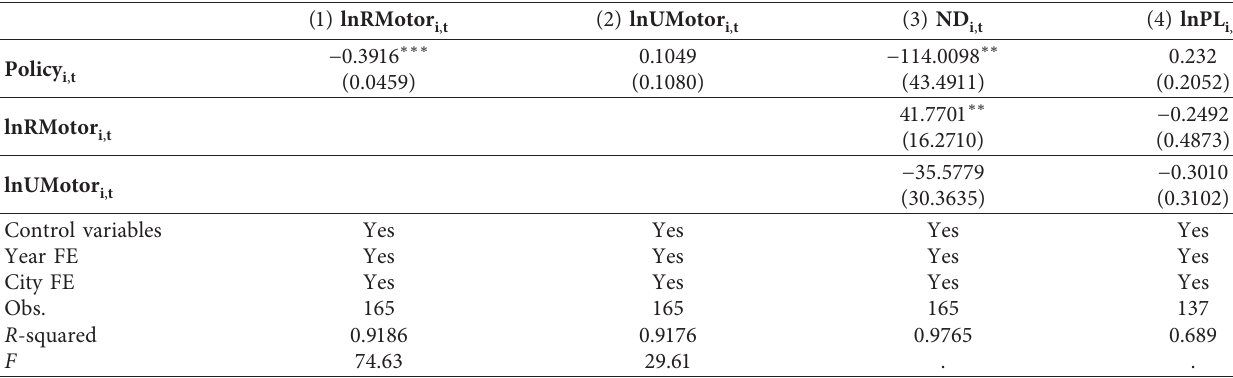
Table 7: The examination of the mechanism of motorcycle bans’ effect.